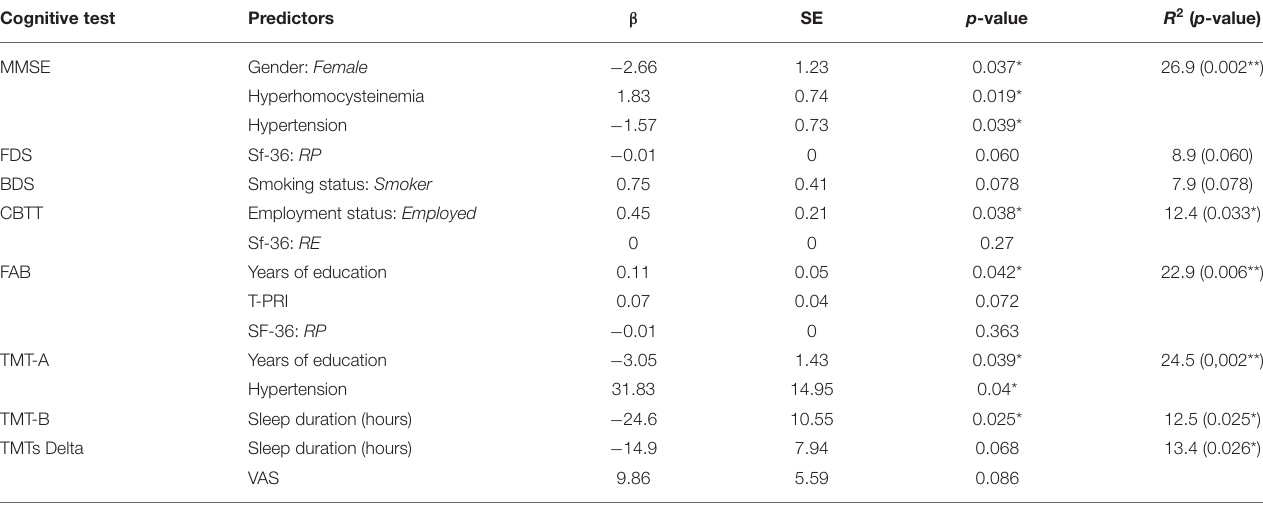
TABLE 10 | Multilinear regression analysis predicting impaired cognitive test in patients with BMS. Cognitive test Predictors β SE